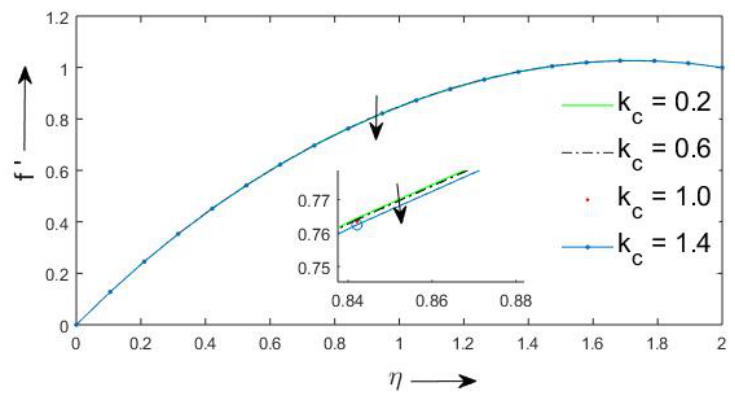
Figure 13: Distribution velocity due to k